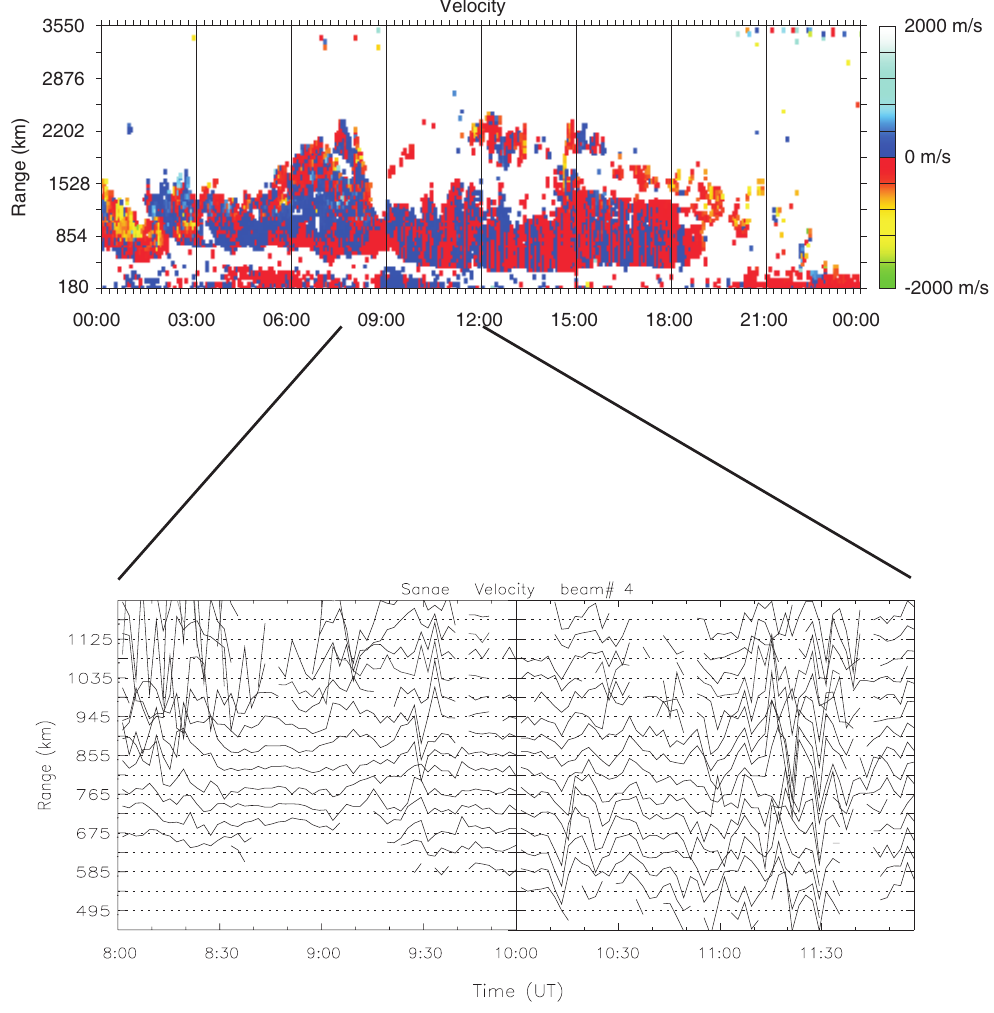
Fig. 4. SHARE range-time velocity plot for 7 June 2000. A four hour subset of beam 4 Doppler velocity is plotted to illustrate FLR